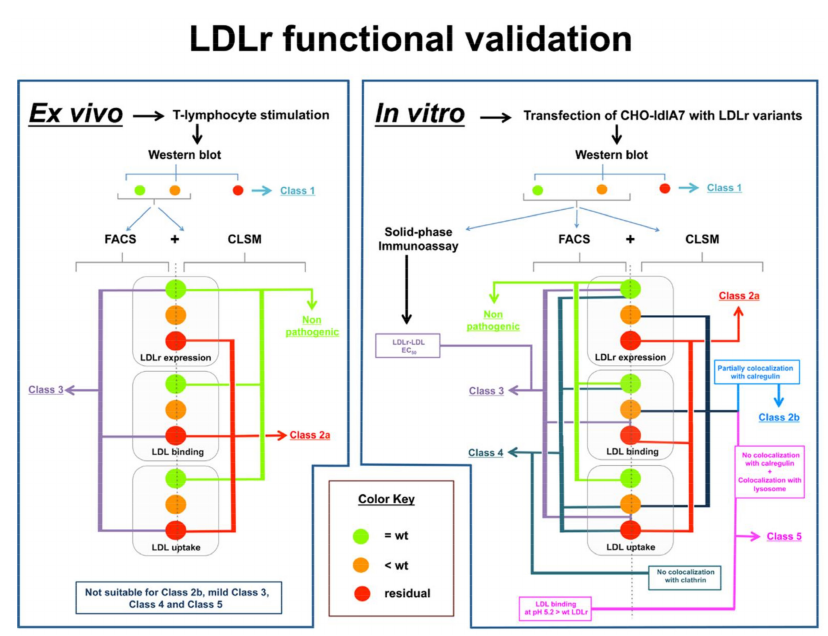
Figure 2. Flowchart of the used methodologies to functionally characterize LDLr variants ex vivo and in vitro. Functional studies of LDLr variants are mainly conducted using two major approaches: 1. ex vivo methods, using cells from Familial Hypercholesterolemia (FH) patients (left-hand panel); 2. in vitro methods using cell lines transfected with the LDLr variant (right-hand panel).